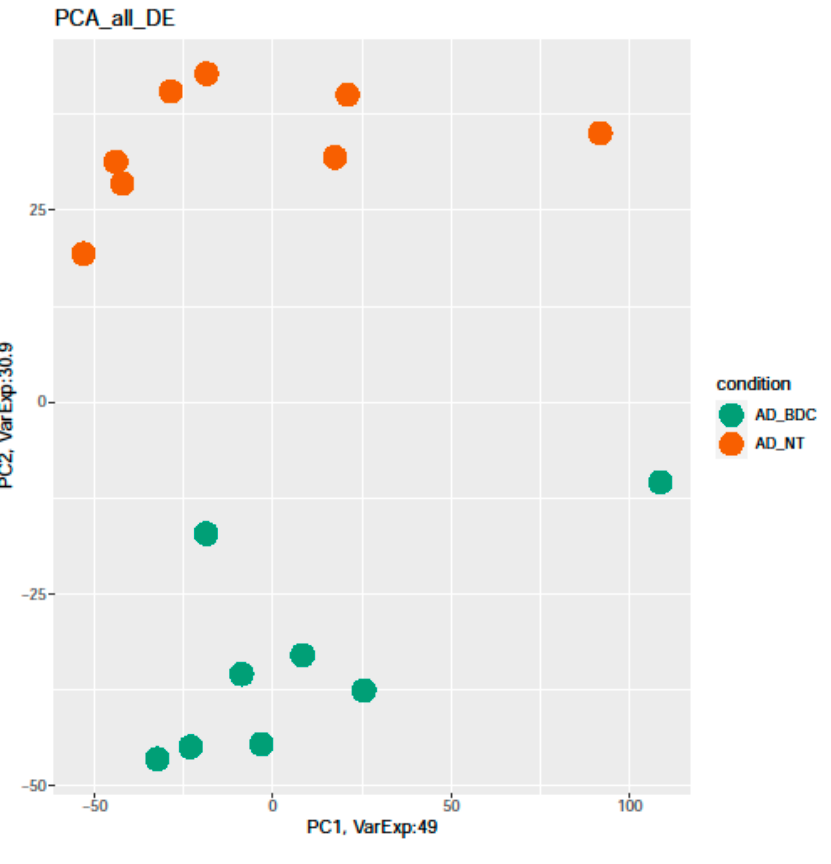
Figure 5. PCA of differentially expressed genes. All comparisons are given between AD untreated compared with AD after BDC-HFn treatment (BDC N° = 8 and CTR_Hfn_BDC N° = 8).